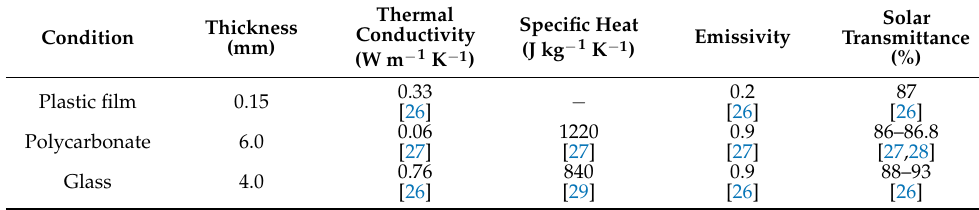
Figure 1. External views and schematics of the three experimental greenhouses used in this study: ( a ) arch-shaped greenhouse covered with plastic (PO) film, ( b ) even-span type greenhouse covered with polycarbonate material, and ( c ) even-span type greenhouse covered with glass. Table 1. Thickness and thermal properties of plastic (PO) film, polycarbonate, and glass.